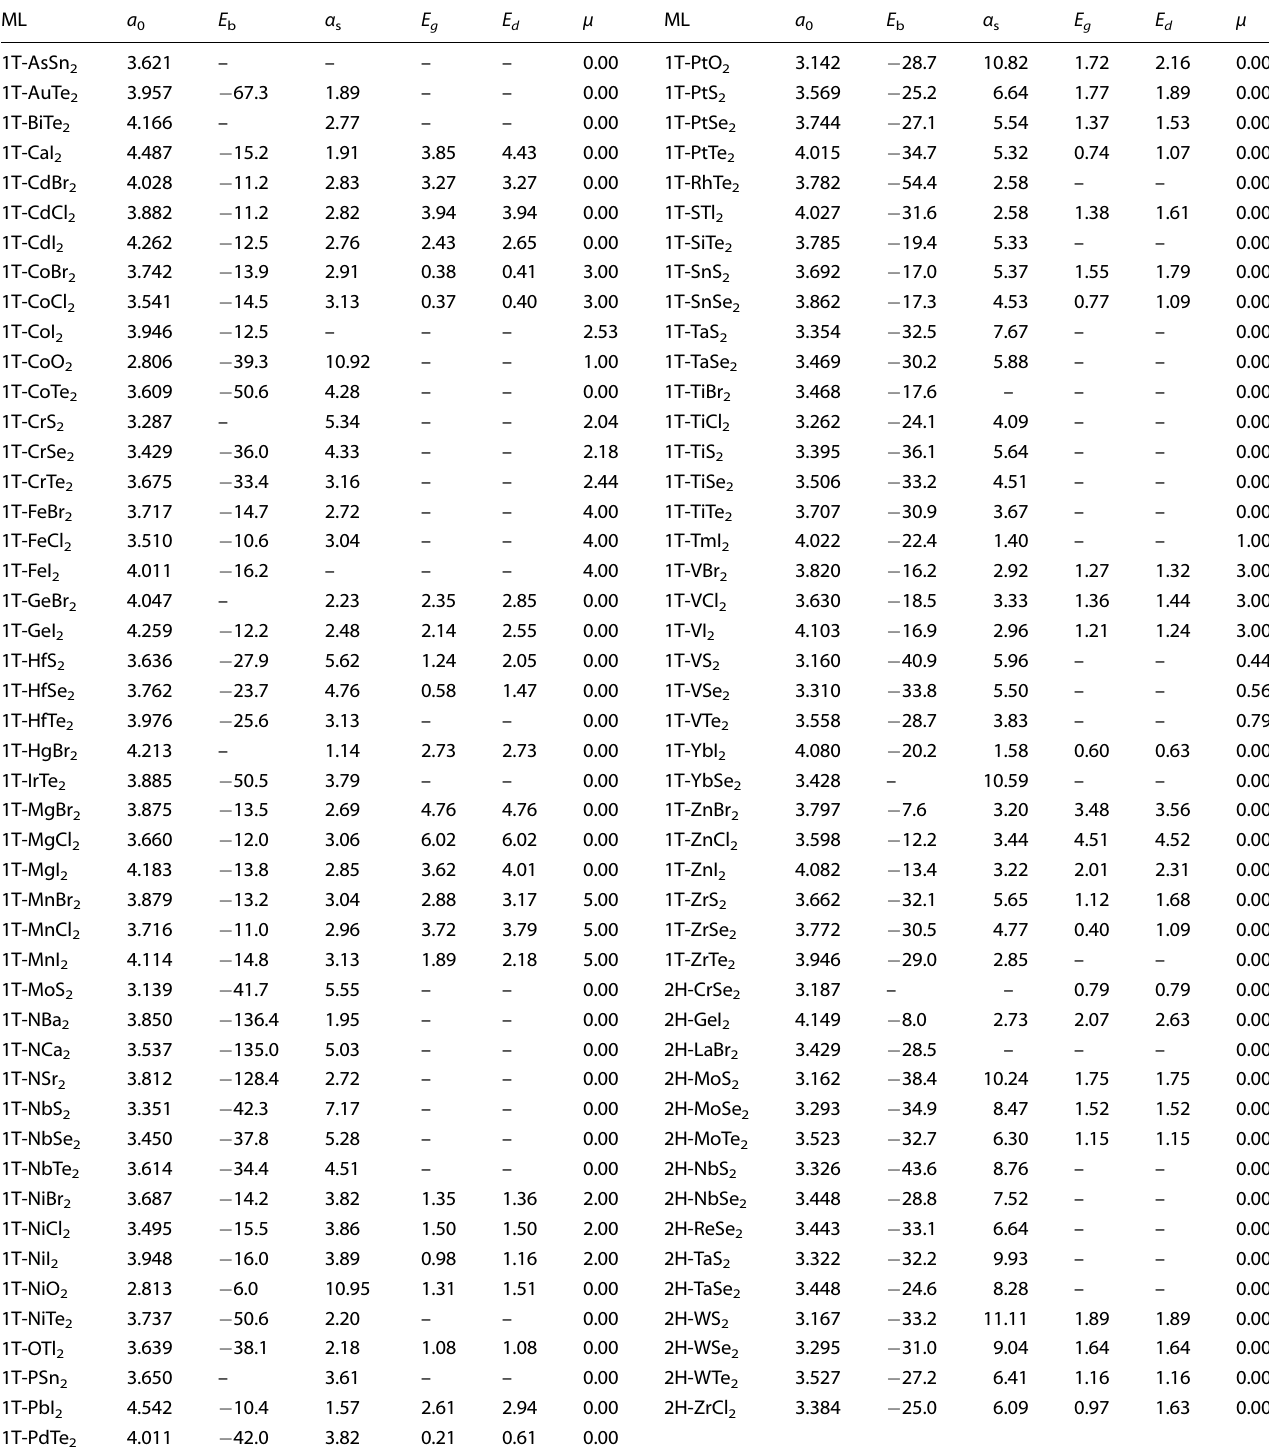
Table 1. Mechanical and electronic properties of 93 hexagonal XY 2 2D materials MLs important for hetero-structure